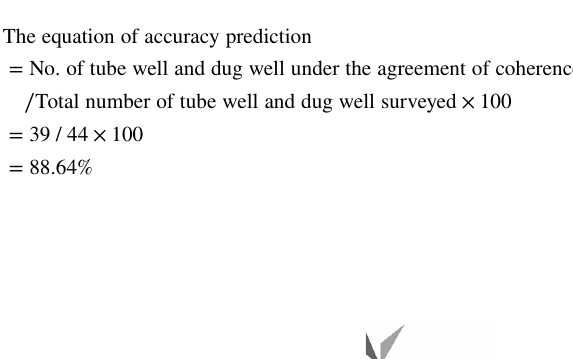
Table 6 expresses similarity between actual class and expected class. A remark of agreement and disagreement is